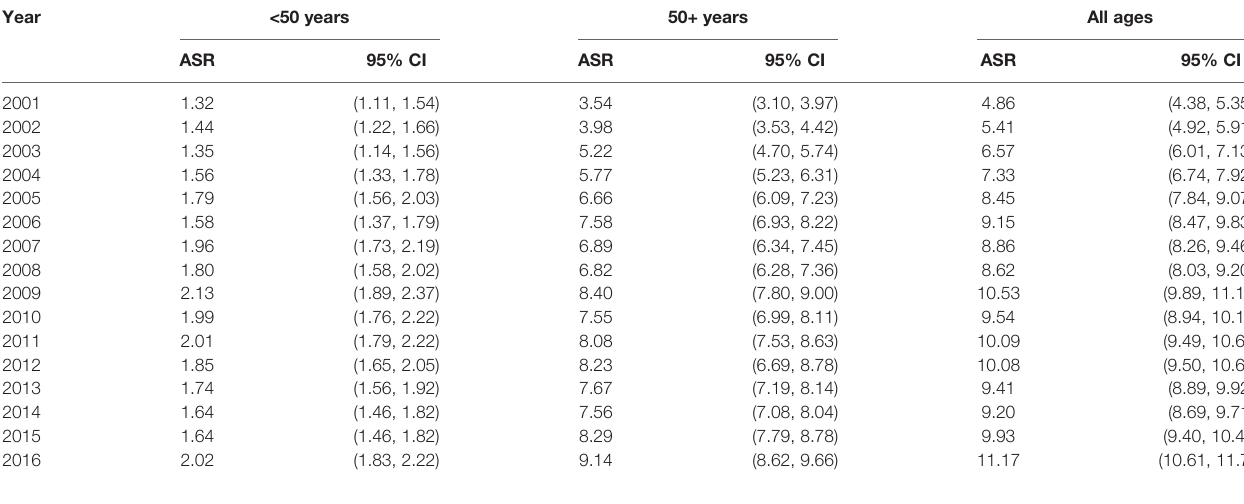
TABLE 2 | Colorectal cancer age-adjusted incidence rates by age group and year, Saudi Arabia, 2001 – 2016.